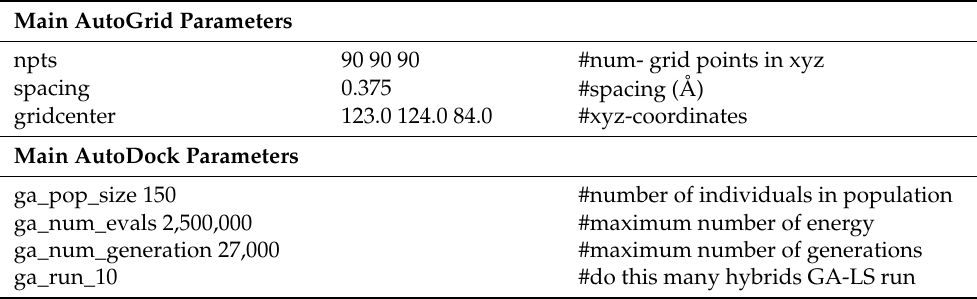
Table 7. AutoDock